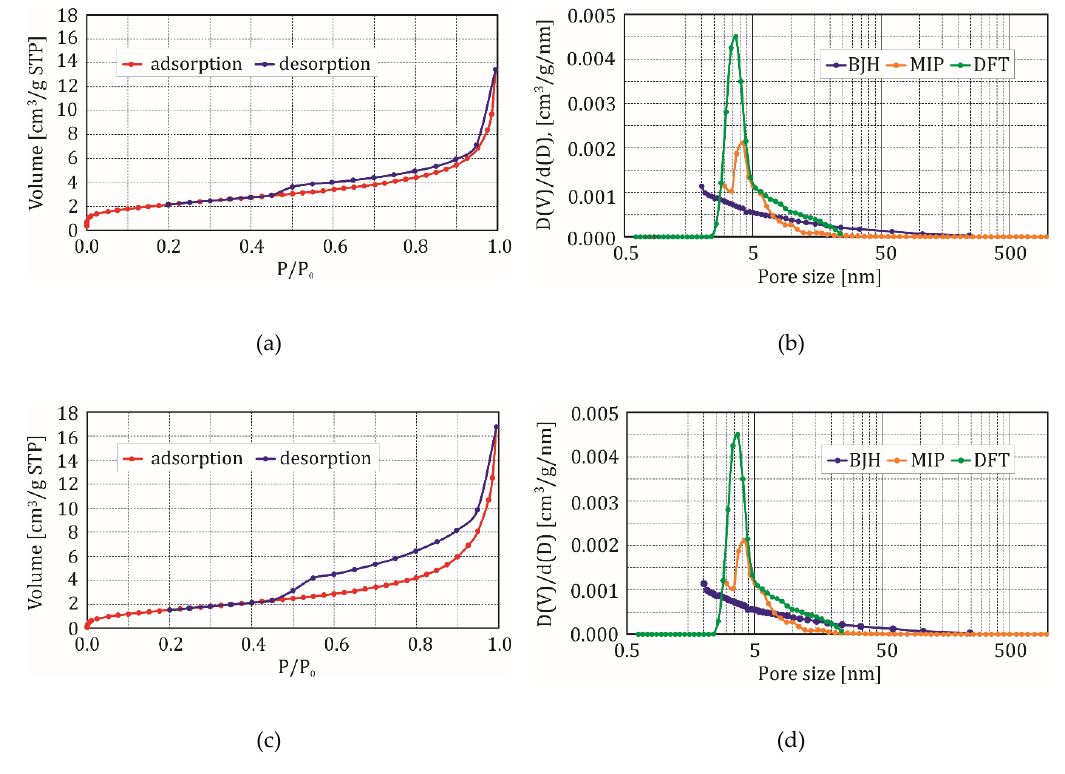
Figure 8. ( a ) Isotherm of adsorption / desorption of nitrogen, 77 K, Well-1(26); ( b ) Pore size distribution according to BJH and DFT models and MIP, Well-1(26); ( c ) Isotherm of adsorption / desorption of nitrogen, 77 K, Well-2(7); ( d ) Pore size distribution according to BJH and DFT models and MIP, Well-2(7).